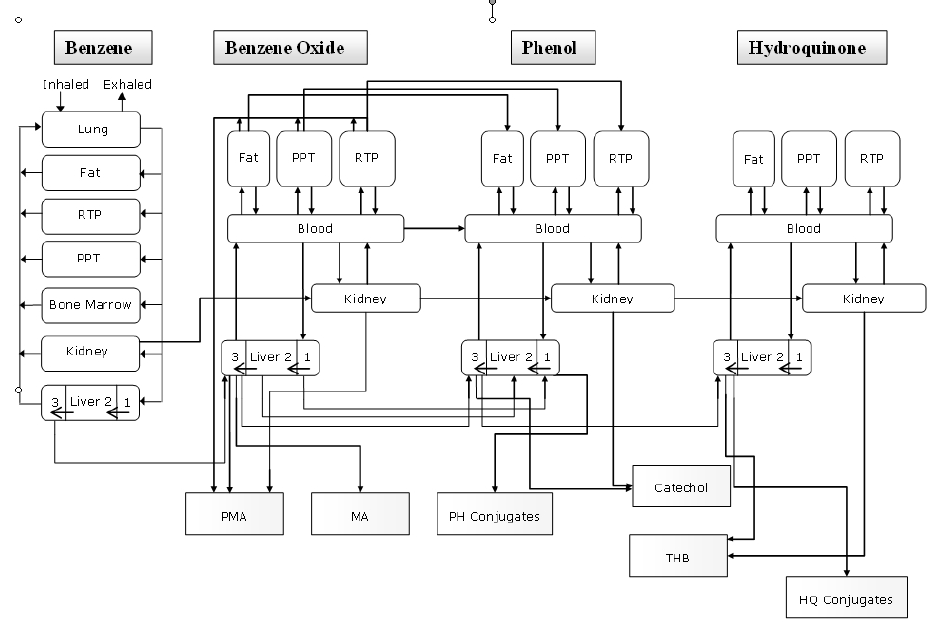
Figure 4 . Conseptual representation of the PBPK